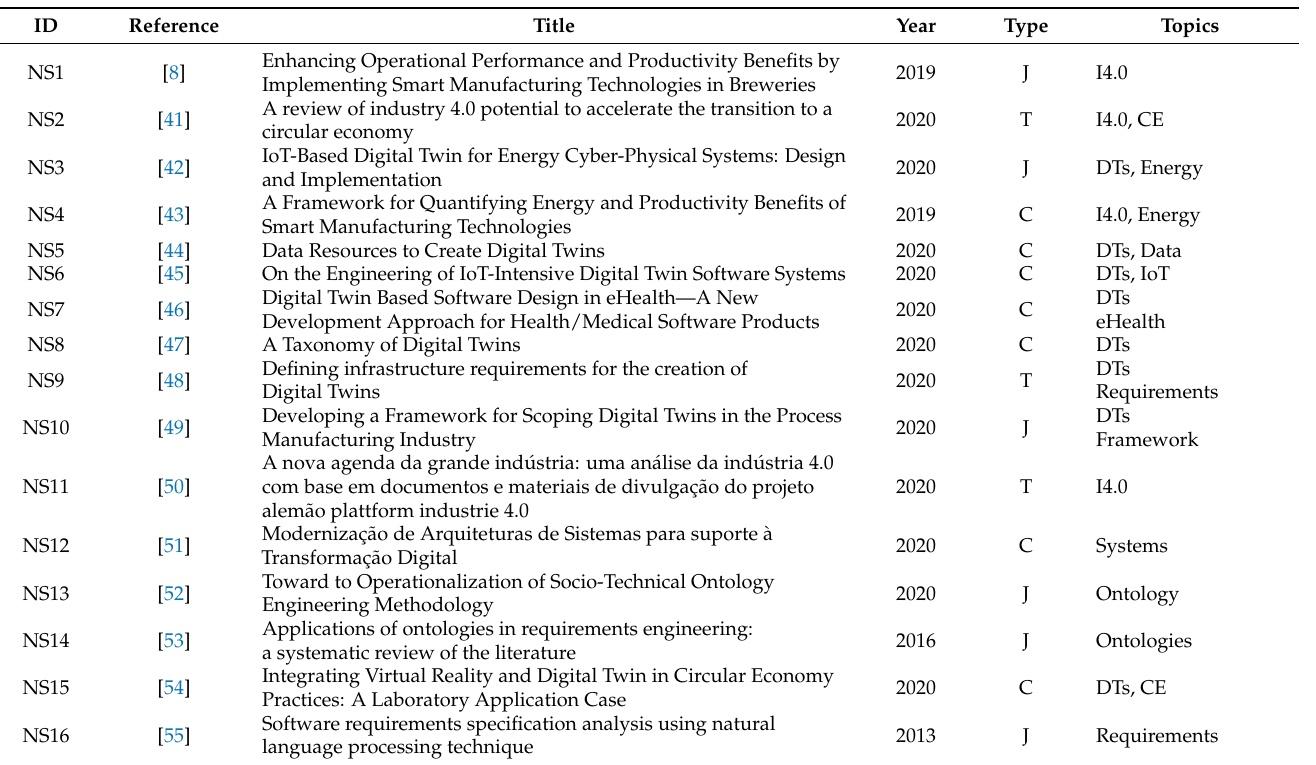
Table 3. Set of selected non-SLR